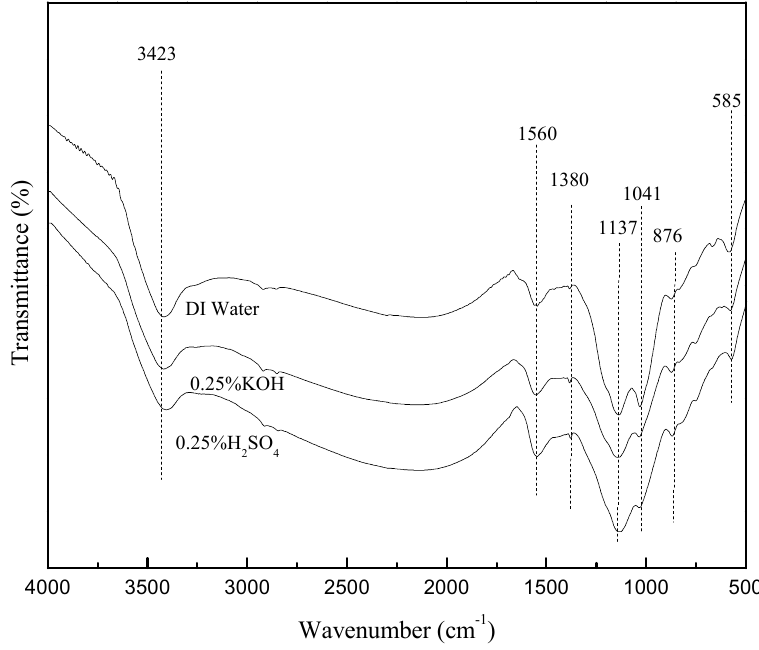
Figure 1. Fourier transform infrared (FT-IR) spectrum of bamboo-derived carbonaceous magnetic solid acid.